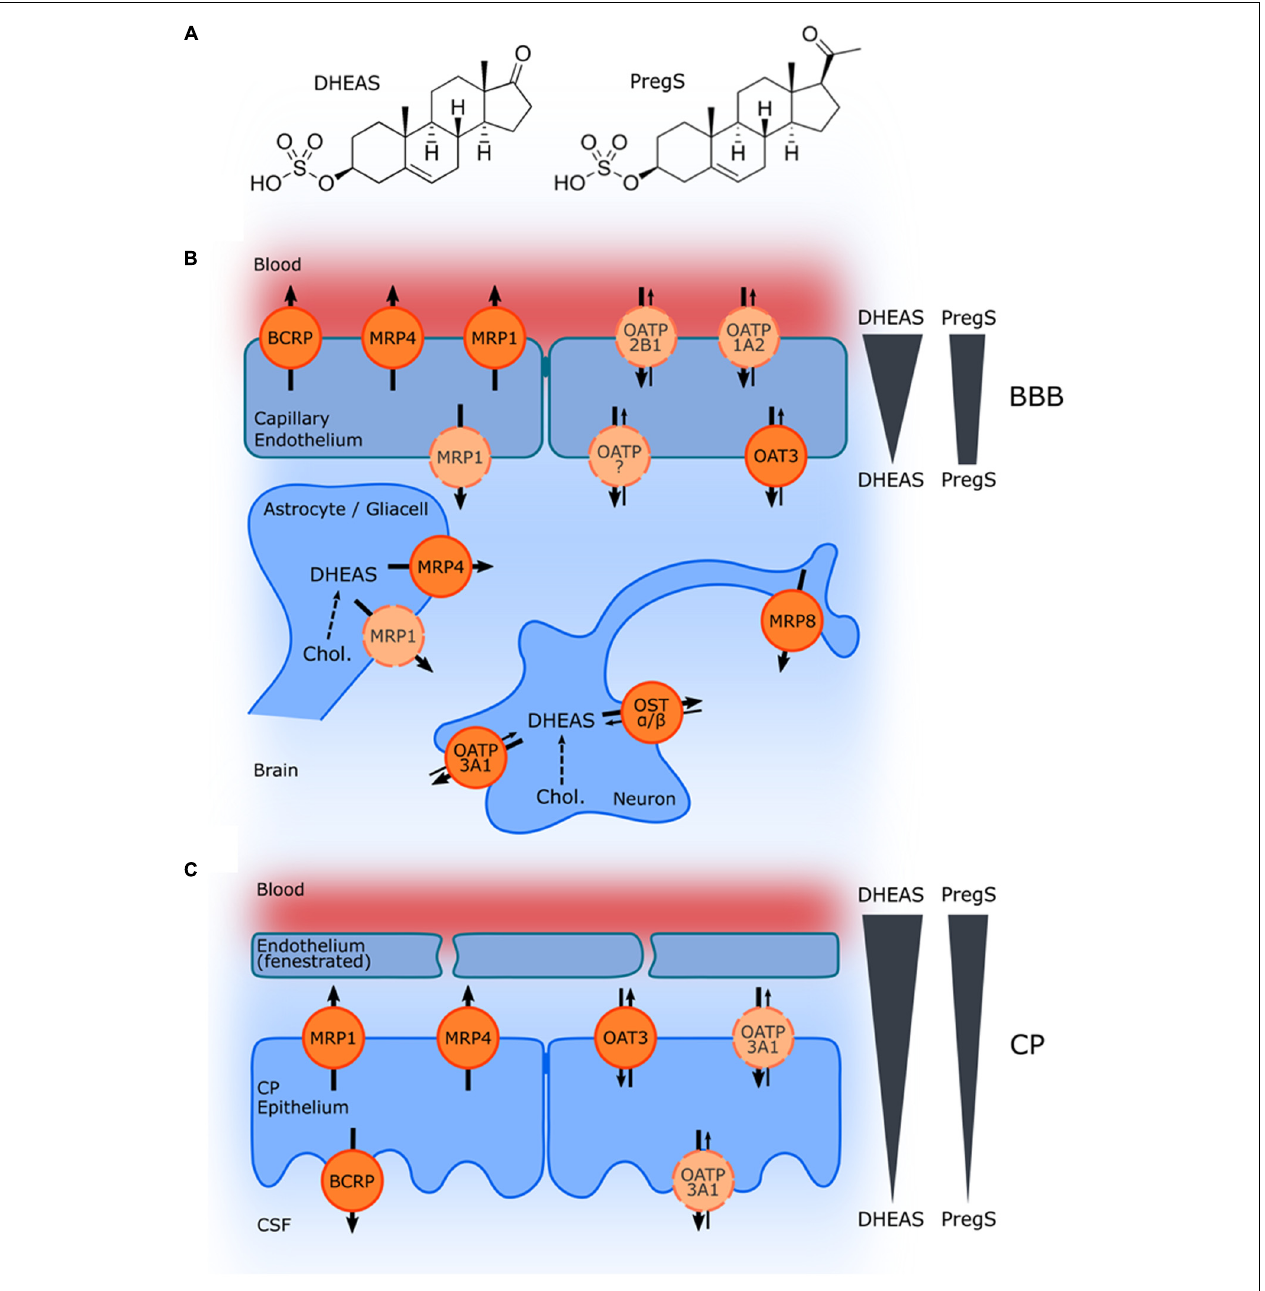
FIGURE 1 | Schematic illustration of ABC and SLC transporters putatively involved in DHEAS and PregS transport and their proposed localization. (A) Structures of DHEAS and PregS. (B,C) The ABC proteins BCRP (ABCG2), MRP1, MRP4, and MRP8 (ABCC1, ABCC4, and ABCC11), and the solute carriers OAT3 (SLC22A3), OATP1A2 (SLCO1A2), OATP2B1 (SLCO2B1), and OST α /ß (SLC51A/B) may be involved in secretion of sulfated steroids from neurons and glial cells and/or in the transport across the BBB (B) as well as in transport at the blood–CSF barrier in the CP (C) . The arrows indicate the directions of substrate transport. Proteins for which there is little or controversial evidence for expression and localization in the basal or apical membrane are indicated in light orange and by a dashed line. Concentration gradients of DHEAS and PregS across the BBB and in the CP are schematically indicated at the right